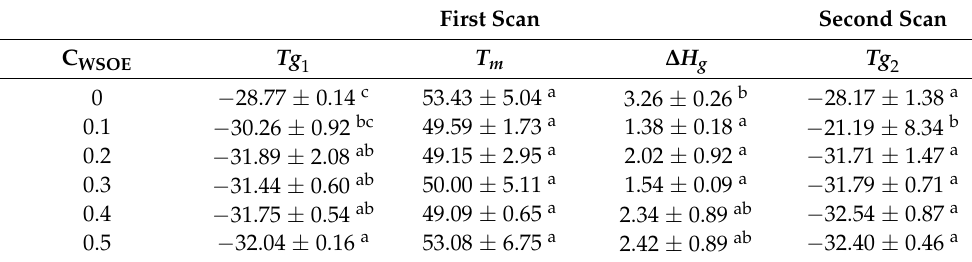
(cid:0) ∆ (cid:1) H g , 2